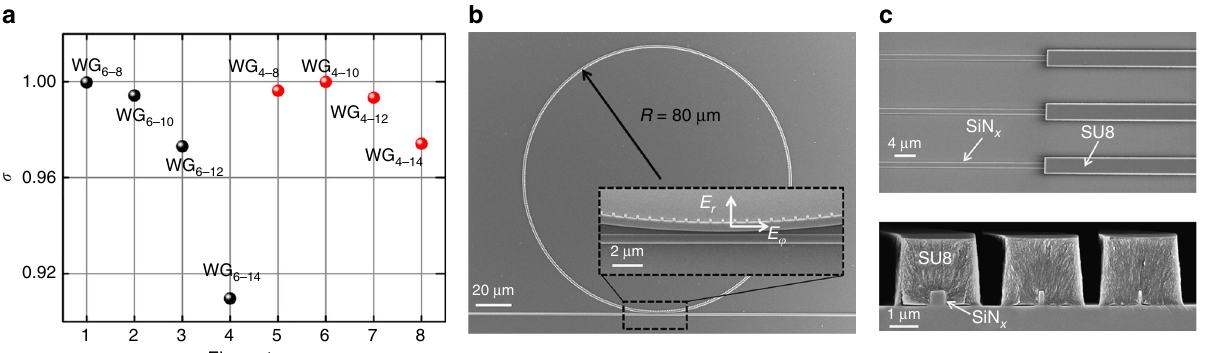
Fig. 3 Calculated transverse-spin states of all designed devices and SEM images of fabricated device WG 6 – 8 . a Calculated transverse-spin states in the evanescent region of all eight sample devices. b SEM image of the device WG 6 – 8 . The inset shows a close-up of the coupling section between the access waveguide and the resonator. c Top: junction point of the tapered coupler consisting of a tapered SiN x waveguide and a SU8 waveguide. Bottom: cross- section views at various positions of the tapered coupler. The minimum width of the SiN x taper (shown in the right-hand side image) is 130 nm